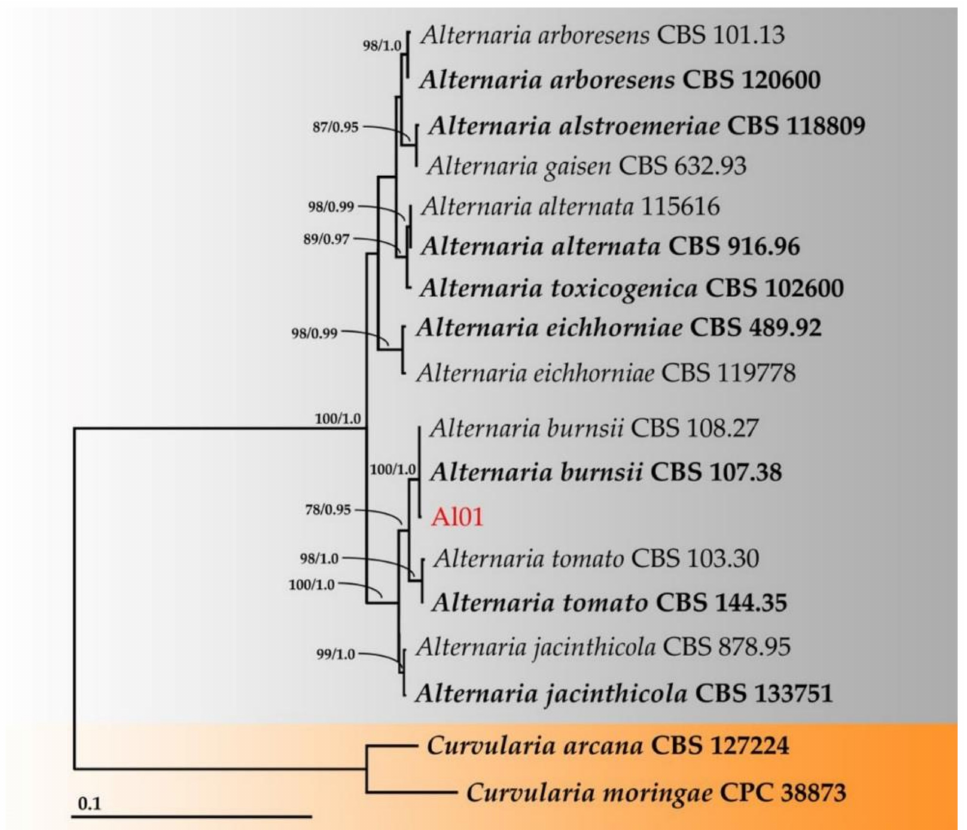
Figure 5. Phylogram derived from the maximum likelihood analysis of 18 taxa of the combined ITS, GAPDH, tef1 , and rpb2 sequences. Curvularia arcana CBS 127224 and C. moringae CPC 38873 were used as the outgroups. The numbers above the branches represent bootstrap percentages ( left ) and Bayesian posterior probabilities ( right ). Bootstrap values ≥ 75% and Bayesian posterior probabilities ≥ 0.90 are shown. The scale bar represents the expected number of nucleotide substitutions per site. The sequence of the fungal species obtained in this study is in red. The type species are in